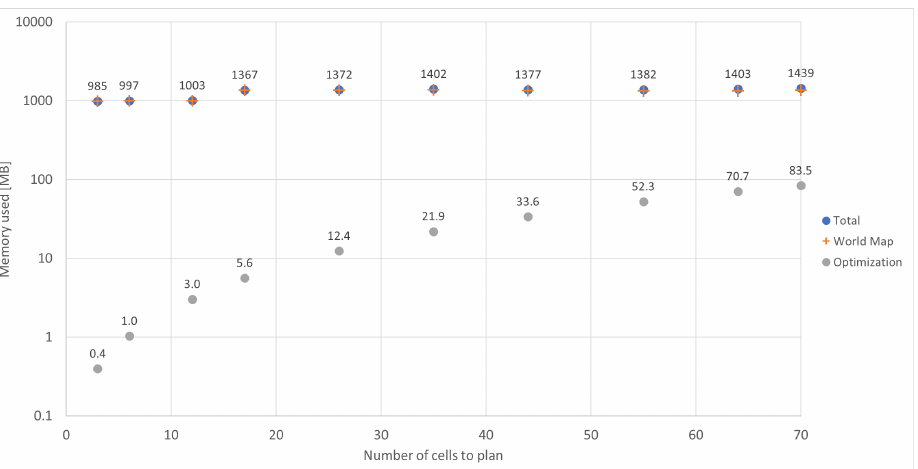
Figure 19. CPSP spacial complexity with the increasing number of